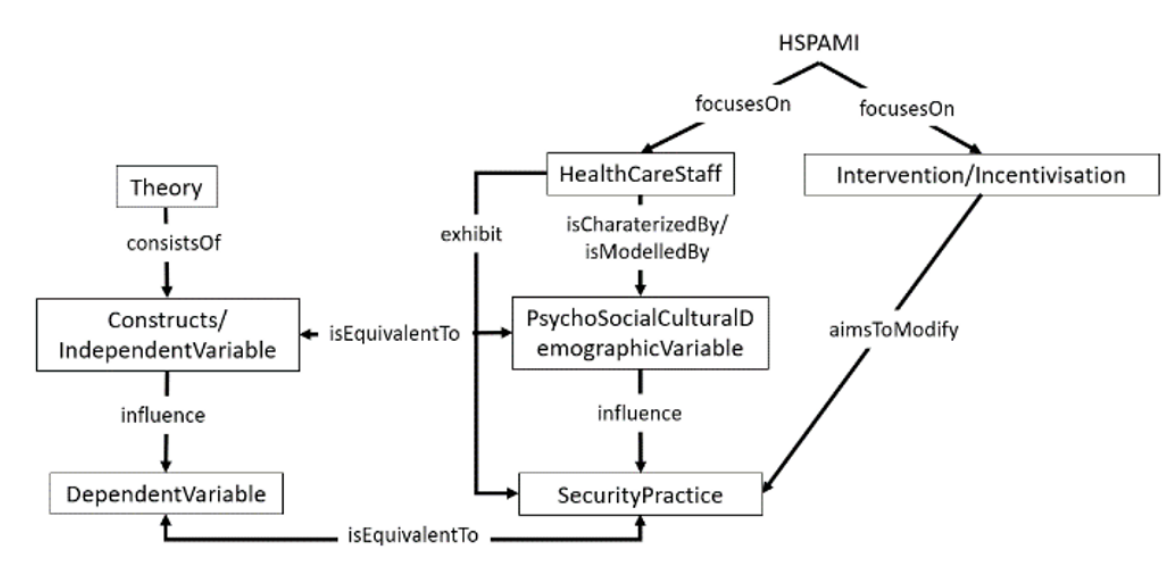
Count, nCategory